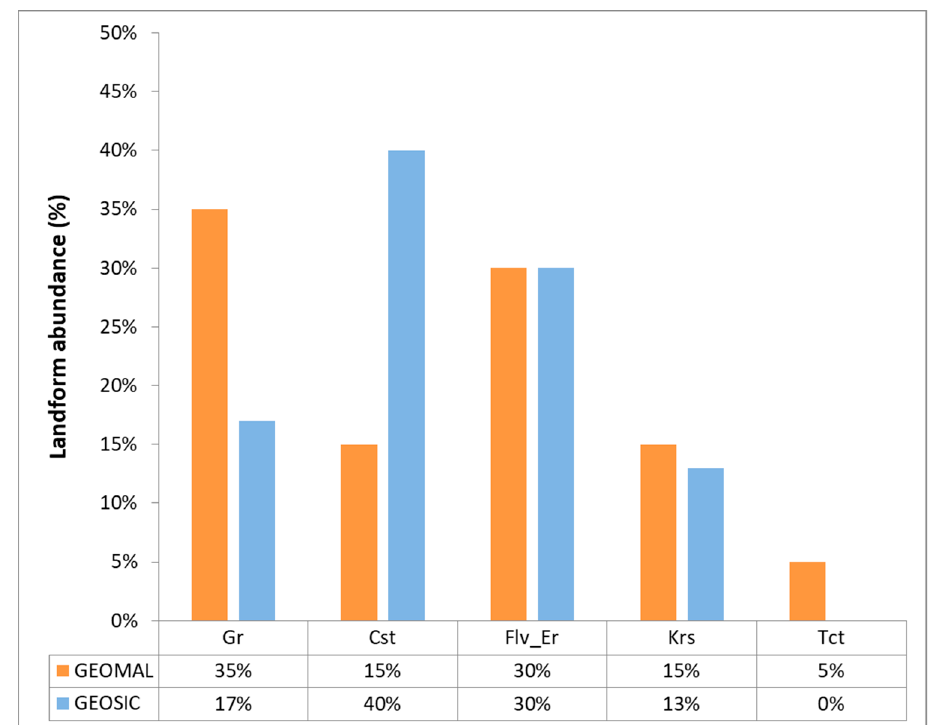
Figure 6. Morphogenetic characterisation and distribution of geosites in Malta (GEOMAL) and Sicily (GEOSIC) study areas (Gr: gravity-induced landforms, Cst: coastal landforms, Flv_Er: fluvial and water erosion landforms; Krs: karst landforms, Tct: tectonic landforms).